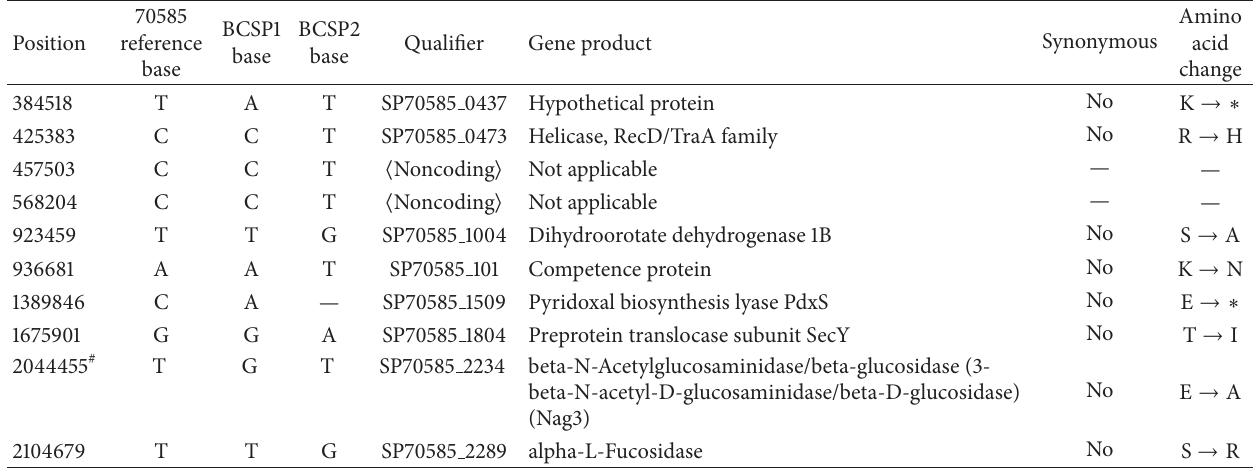
Table 2: SNVs between BCSP1 and